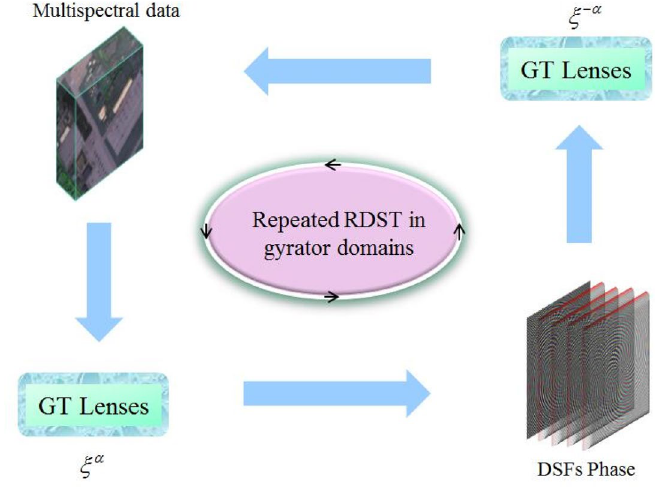
Figure 2. The schematic diagram of random devil’ spiral Fresnel transform.